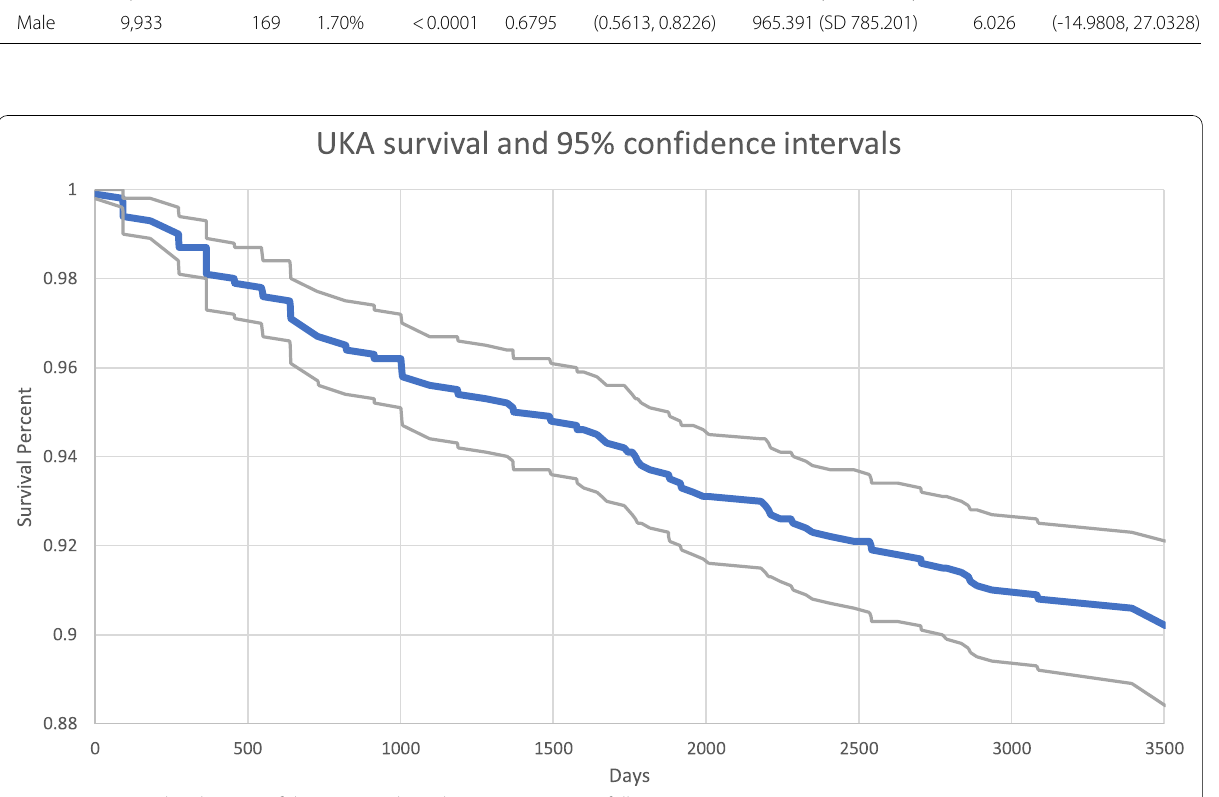
Fig. 4 UKA survival and 95% confidence intervals (with a minimum 8 year follow up)